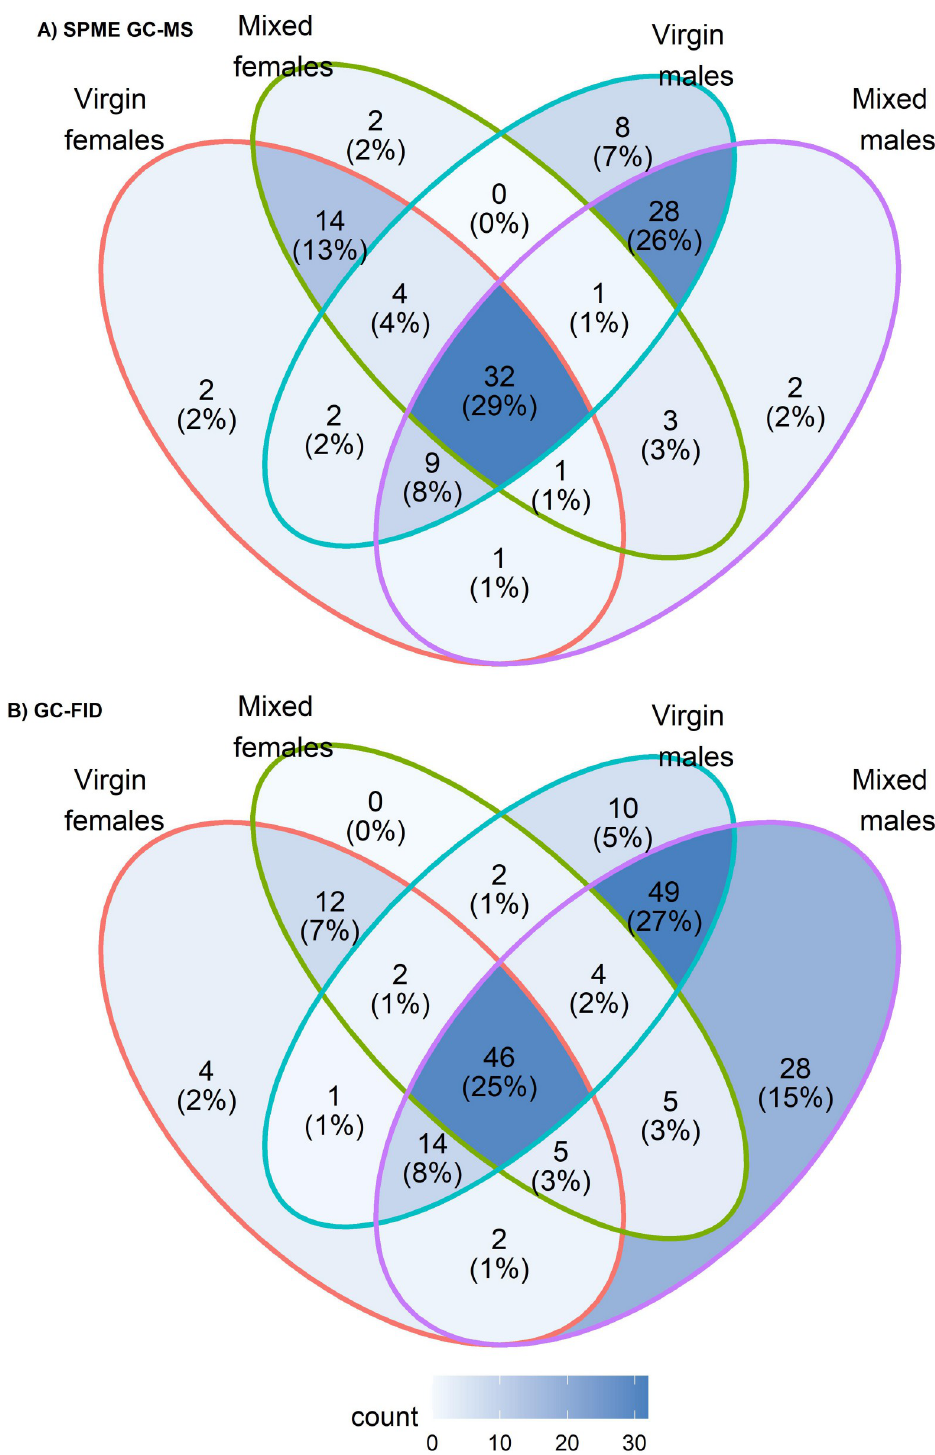
Fig 1. Venn diagrams showing the numbers of peaks detected in each sex/mating history category in the SPME GC-MS (A) and GC-FID analyses (B).